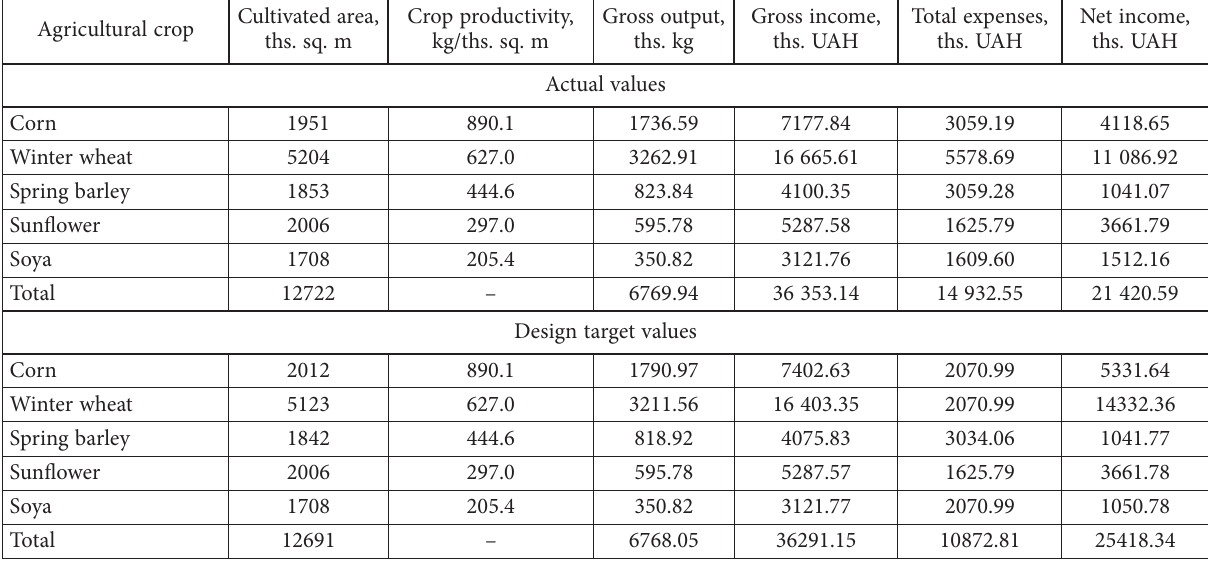
Table 6. Agricultural enterprise land consolidation economic effectiveness (option